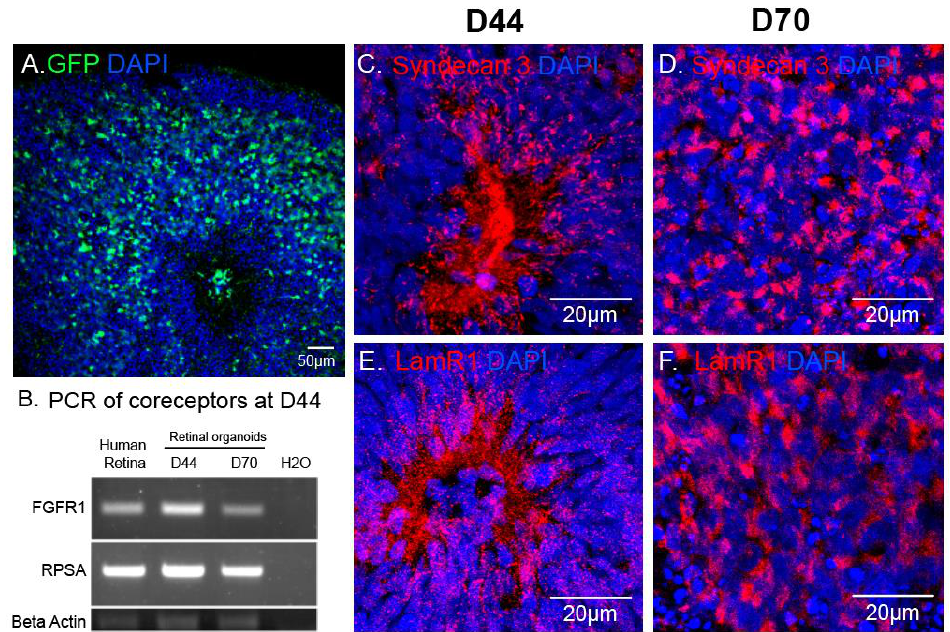
Figure 4. AAV mediated reporter gene expression in relation to the distribution of AAV receptors in hiPSC-derived retinal organoids. ( A ) Confocal image of a D70 retinal organoid infected with AAV2-7m8-CAG-GFP, GFP signal was amplified using chicken polyclonal anti-GFP antibody. ( B ) RT-PCR showing expression of co-receptor genes (Laminin receptor1 (RPSA) and FGFR1) in the mature human retina, D40 and D70 retinal organoids. ( C–F ) Confocal images showing localization of Syndecan 3 and Laminin receptor 1 in 3D retinal organoids at di ff erent stages of di ff erentiation. Scale bars: A, 50 μm; C – H, 20 μm.